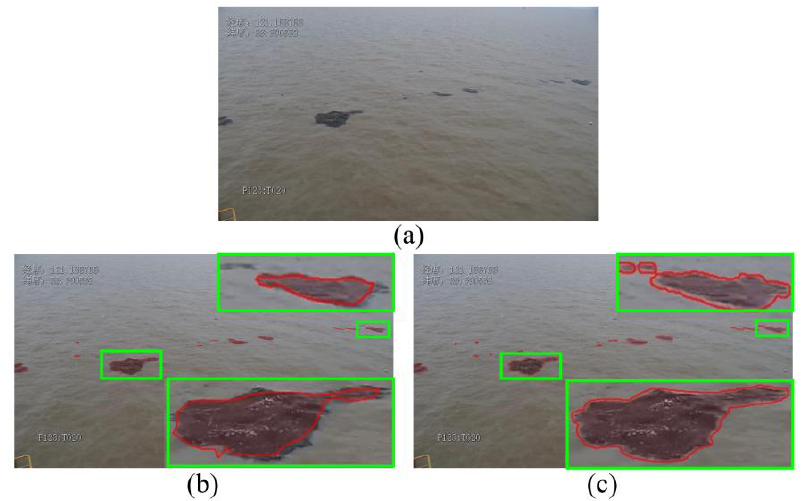
Figure 10. The comparison between Mask R-CNN and Mask Transfiner. ( a ) is the source image. ( b ) is the Mask R-CNN result with ResNet-101. ( c ) is the Mask Transfiner result with ResNet-101. To better produce the performance of the network in the boundary area, we zoom in on the area in the green